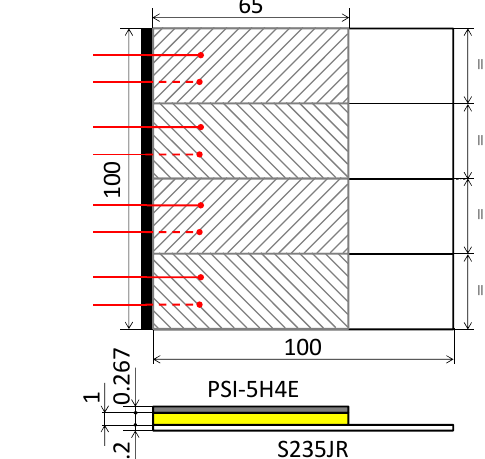
Figure 1: Sketch of the fractal-inspired geometry for the piezoelectric converter prototype